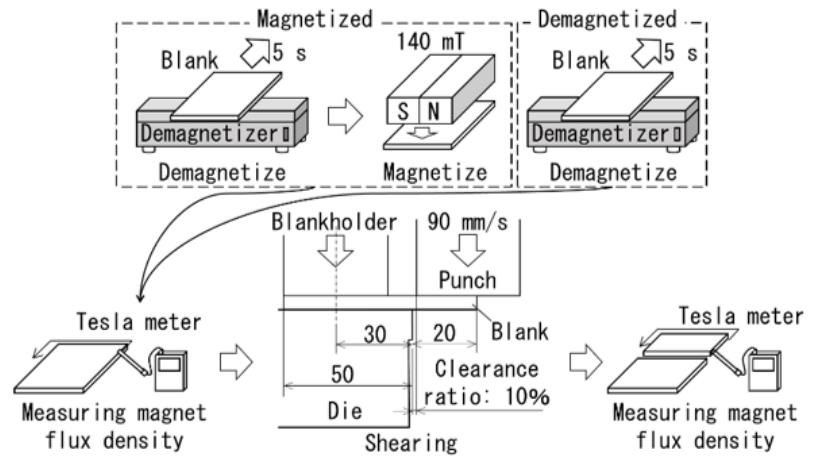
Figure 2. Method of investigating magnetic flux density of magnetized and demagnetized sheets before and after shearing.